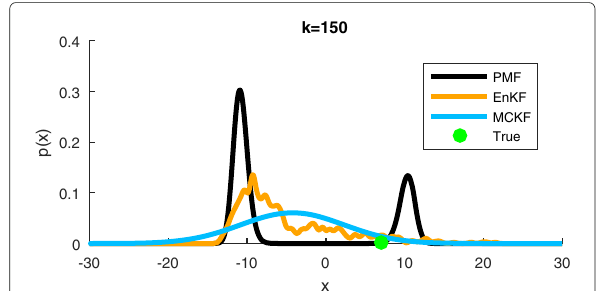
Fig. 4 Filtering densities p ( x k | y 1: k ) by PMF, EnKF, and MCKF for k = 150. Otherwise similar to Fig. 3